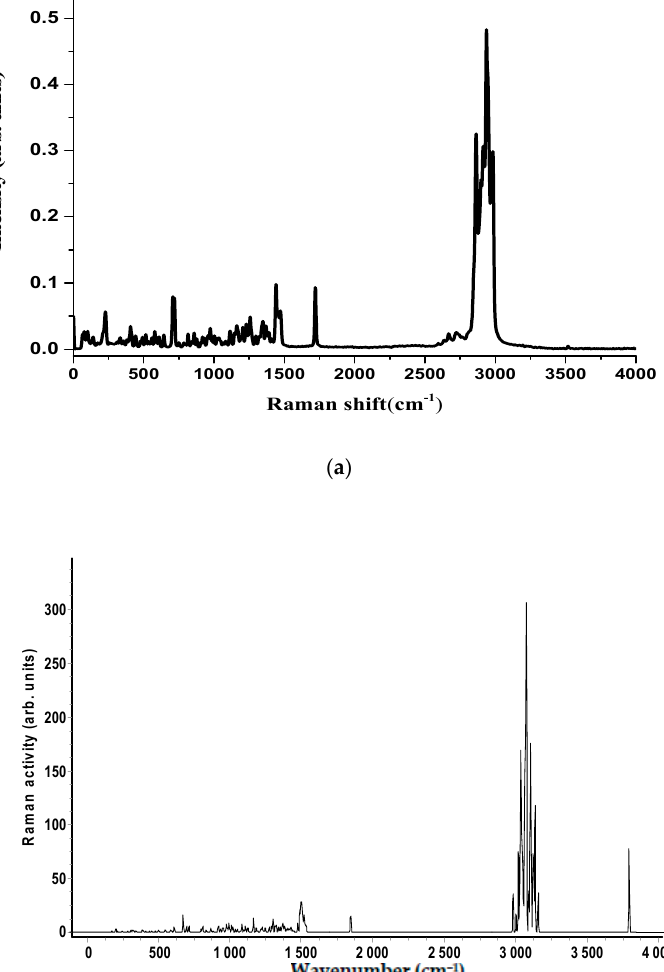
Figure 2. ( a ) FT-Raman spectrum of oxandrolone molecule in the wavenumber range 4000–0 cm − 1 ; ( b ) The simulated Raman spectra of oxandrolone computed with a B3LYP/6-311G (d, p) level of theory. Experimental conditions: power = 30–100 mW, number of scans = 1000–2000 scans, exposure time = 10 s for each spectrum. Baselines have been subtracted for all the